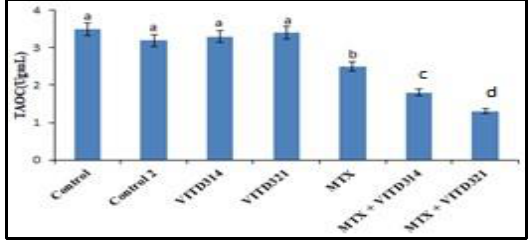
Figure 2. Effects of various treatments on total antioxidant capacity (TAOC) levels in the jejunum tissue of rats. Each value represents mean ± standard error of means